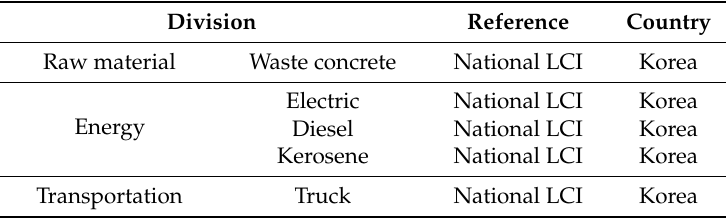
Table 1. The Life Cycle Index (LCI)